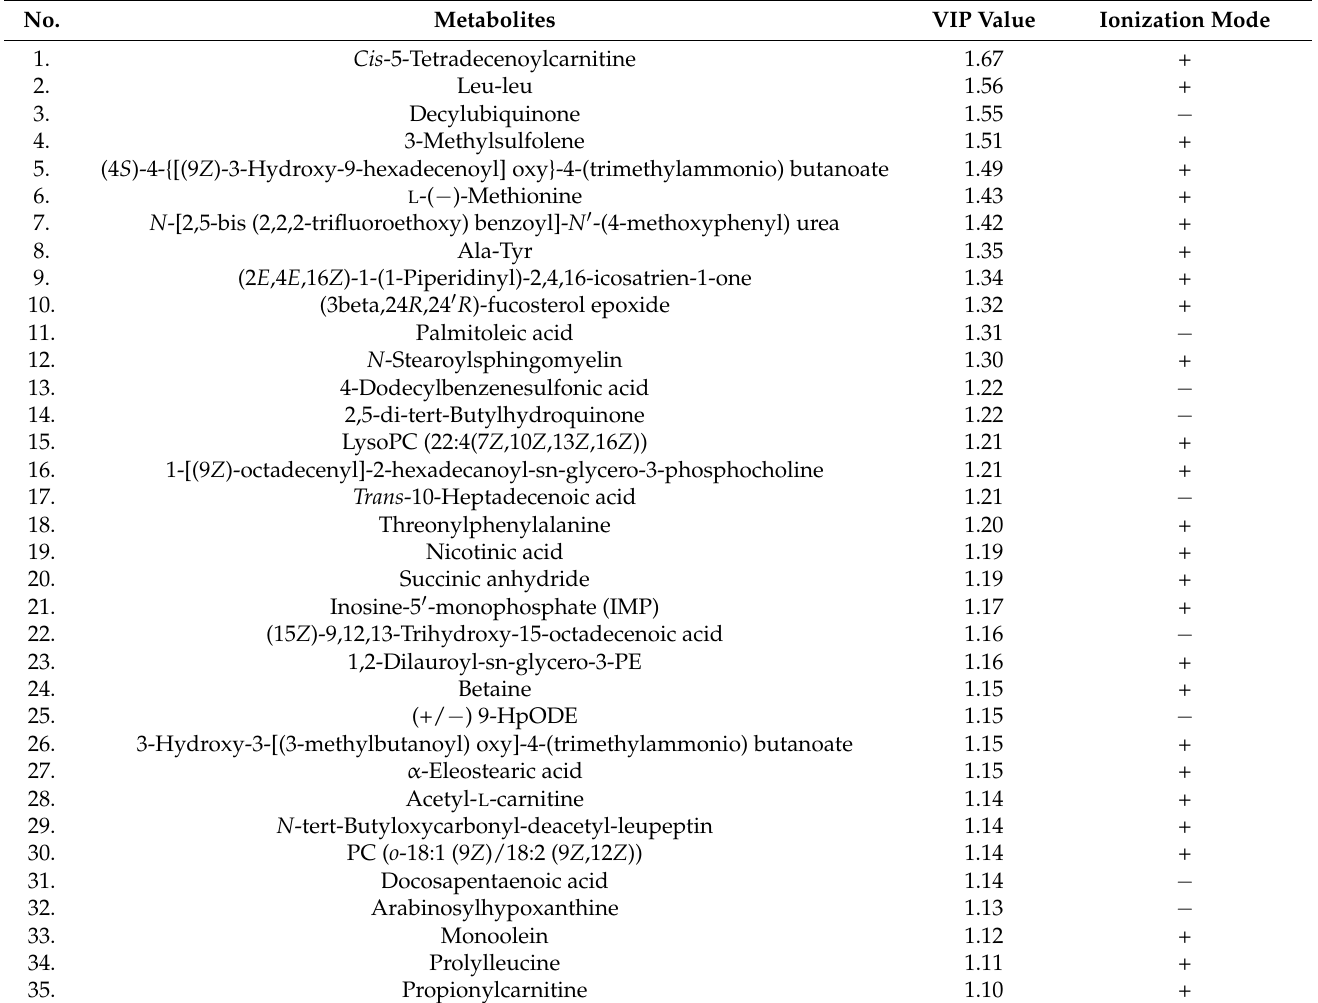
Table 1. Potential metabolite markers for differentiation of meatballs made from beef, pork, and a mixture of beef-pork obtained from VIP